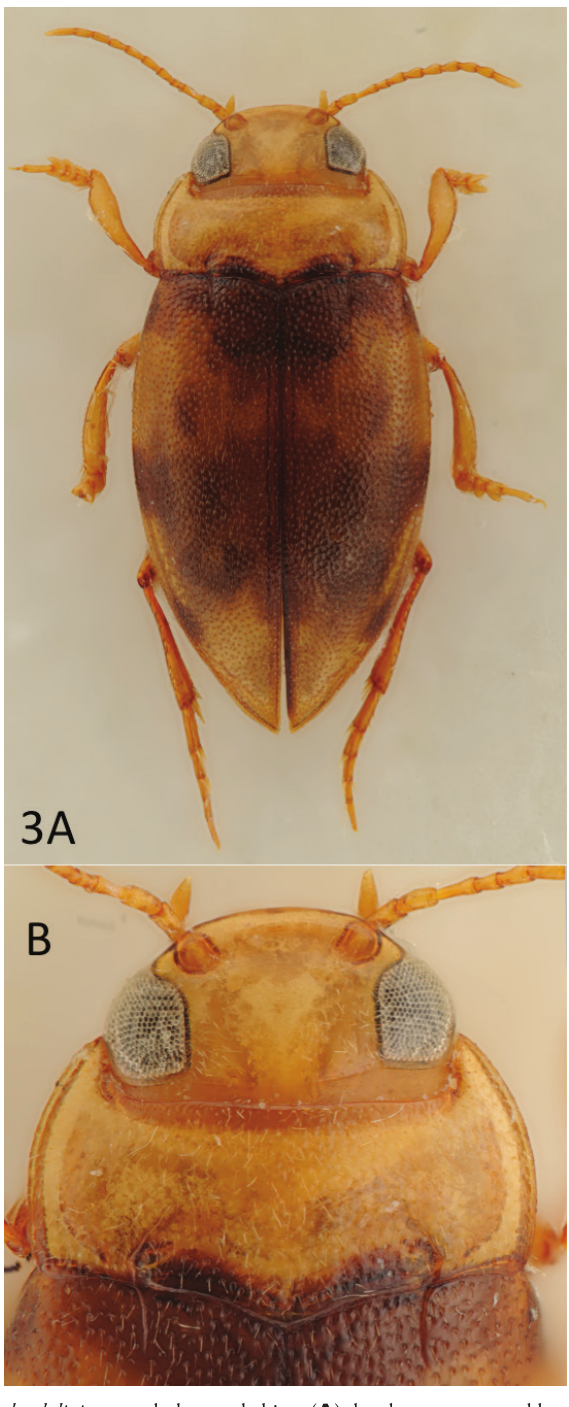
Figure 3. Leiodytes kualalipis sp. n., holotype, habitus ( A ), head, pronotum and base of elytra ( B